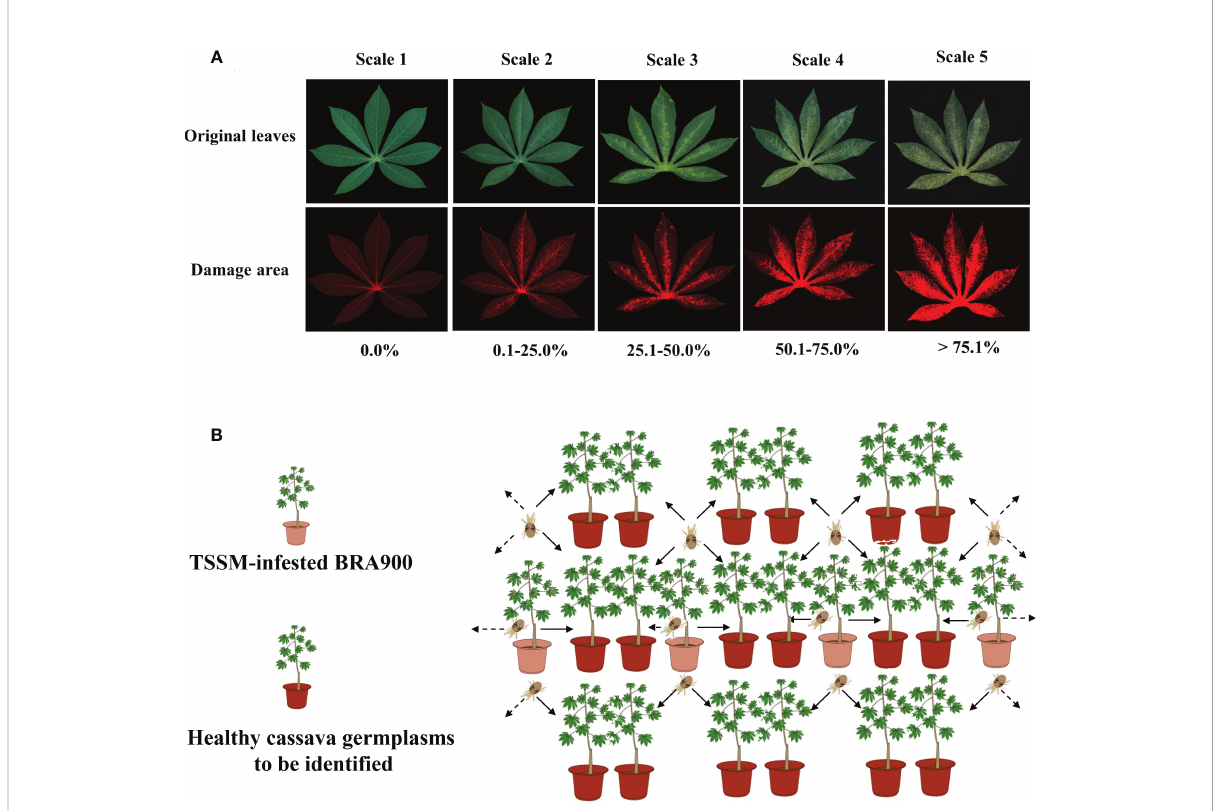
FIGURE 1 Methodology of identi fi cation of cassava germplasm resistance to two-spotted spider mite in greenhouse. (A) Classi fi cation of mite damage scales of cassava leaves. The upper panel indicated the original leaf images, and the lower panel indicated the mite damage area that was visualized by specialized leaf image analysis software. (B) Sketch map of mite inoculation in greenhouse identi fi